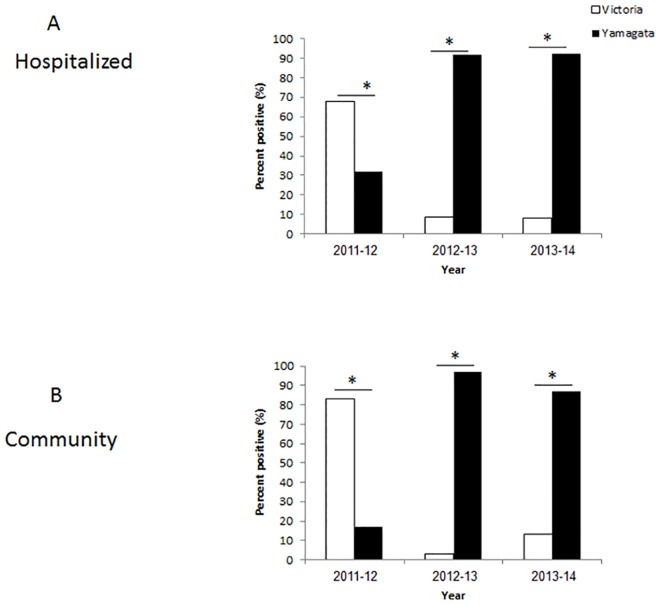
Temporal of influenza B infection.The percentages of hospitalized (A) and community (B) patients, during the winter seasons of 2011–2014. *p<0.05.